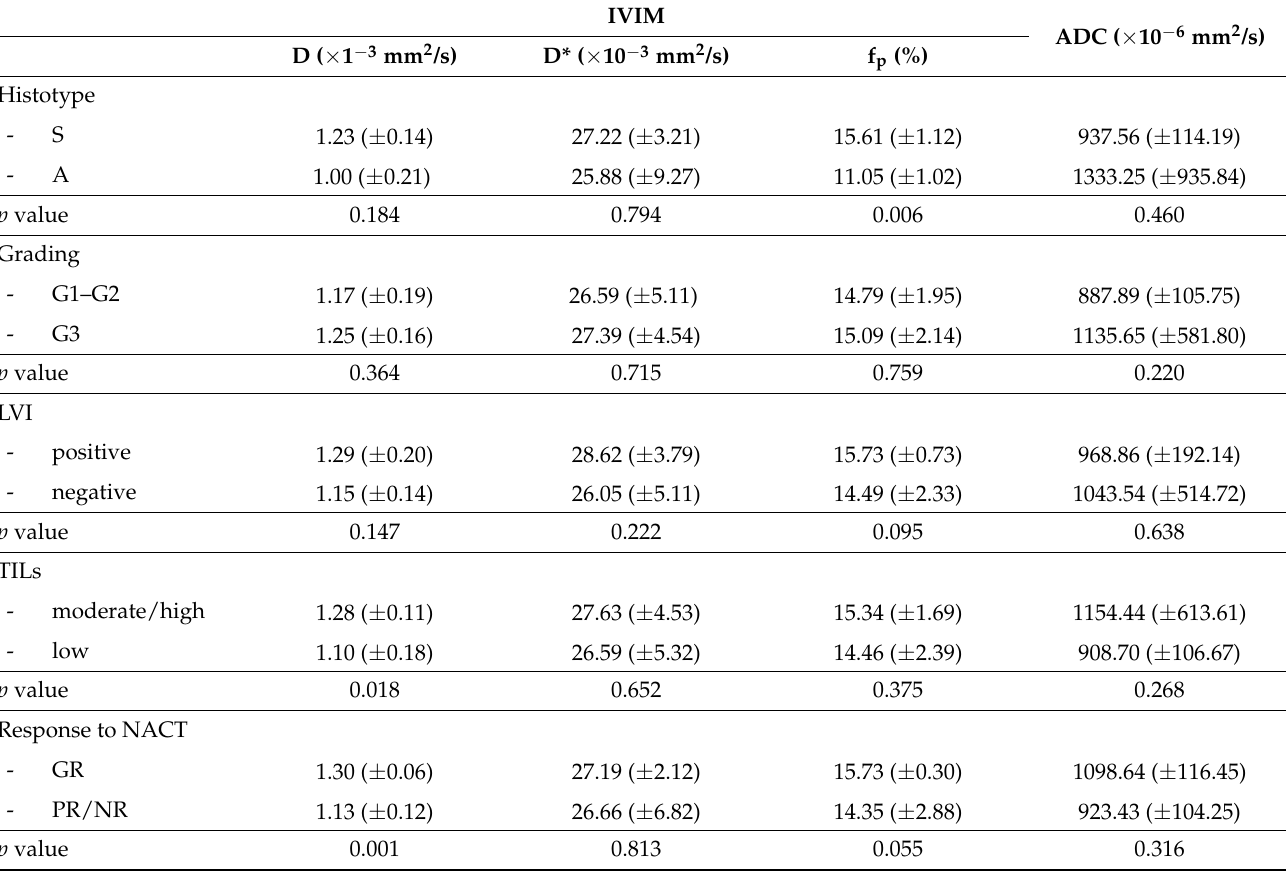
Table 3. Results—Differences between quantitative MRI parameters in different histological parameters and in response to neoadjuvant chemotherapy. Statistically significant differences in light grey